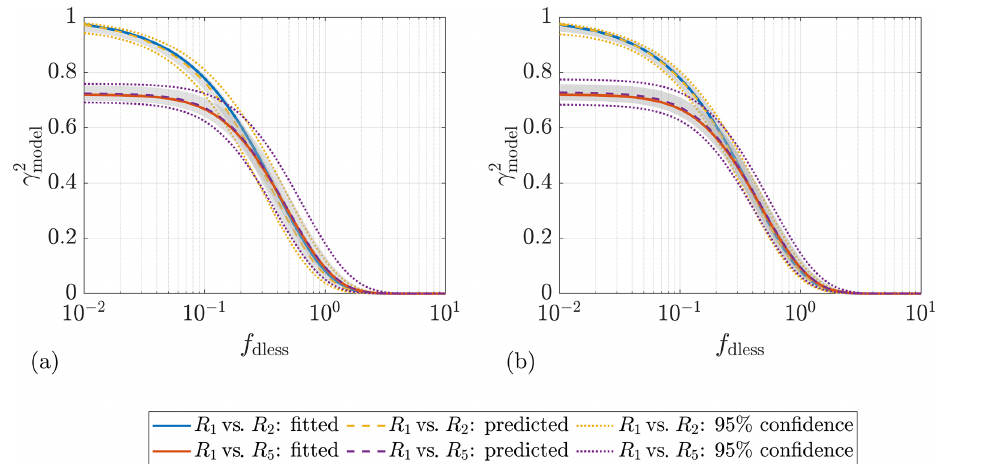
Figure 12. Example predicted coherence with 95% confidence interval for two different measurement separations of Lidar Complex. (a) Pre- diction with lidar data: a for case 6 and b for case 11. (b) Prediction with sonic data: a for case 13 and b for case 17. The shaded areas indicate the RMSE interval. The input predictor data and the estimated coherence are from the case-study example of Lidar Complex: 7 De- cember 2013 at 12:00–12:30. The mean lidar wind speed U l ranges from 7.3 to 7.7ms − 1 , and the lidar-measured turbulence intensity I T , l ranges from 0.10 to 0.12, for different range